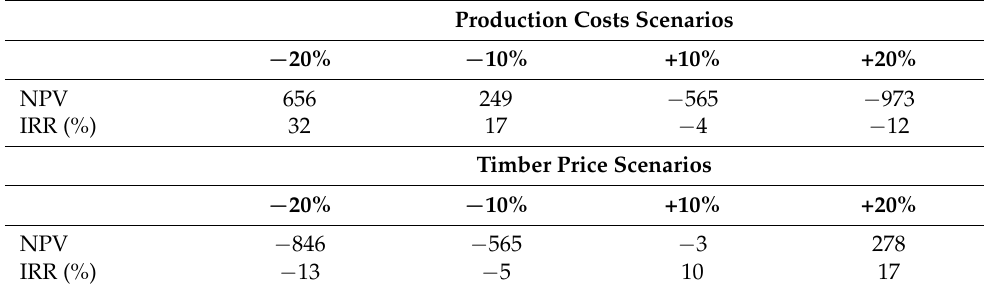
Table 5. Financial indicators from increased and decreased of production costs and timber price based on a case study in Las Cañadas. NPV = Net Present Value, IRR = Internal Rate of